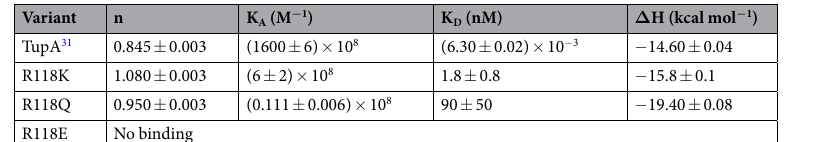
Table 2. ITC analysis of tungstate binding to TupA variants at 30 °C. In each case 10 µ M protein was used for the titrations. n = measured stoichiometry of